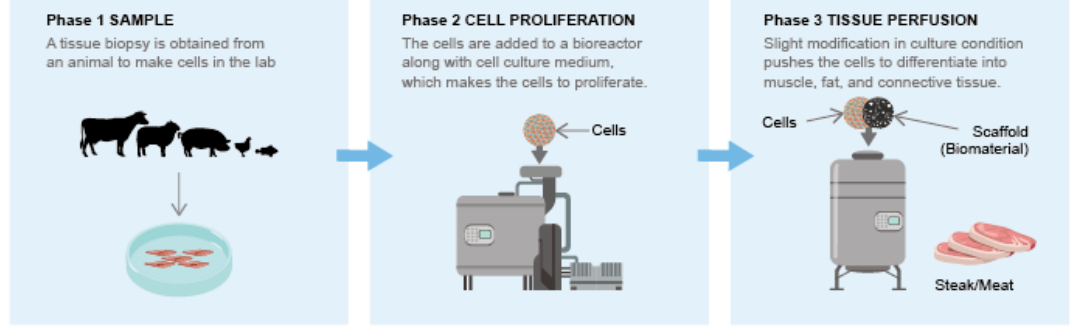
Figure 3. The production of meat in a bioreactor at the industrial scale.